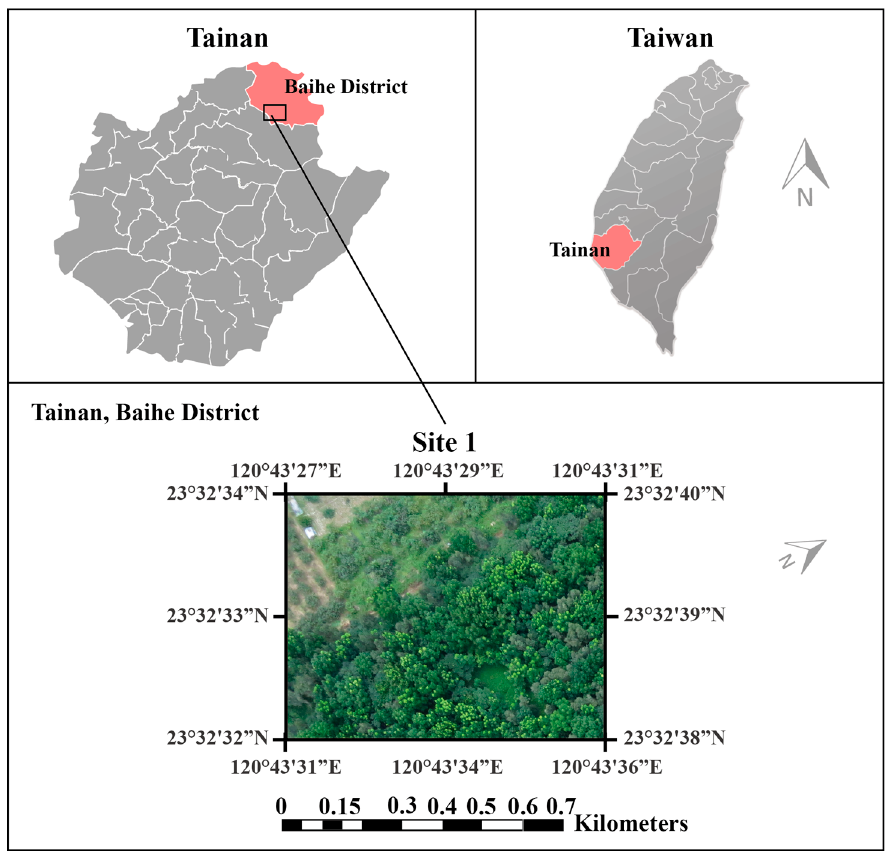
Figure 10. Study site at Baihe District, Tainan, Taiwan.